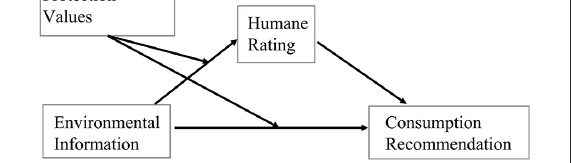
FIGURE4 Conceptual model of the moderated mediation analysis used to explore the influence of the moderator (environmental protection values) on the relationship between the independent variable (environmental information) and the mediator (humane rating) as well as on the relationship between the independent variable and the outcome variable (consumption recommendation). Adapted from Hayes